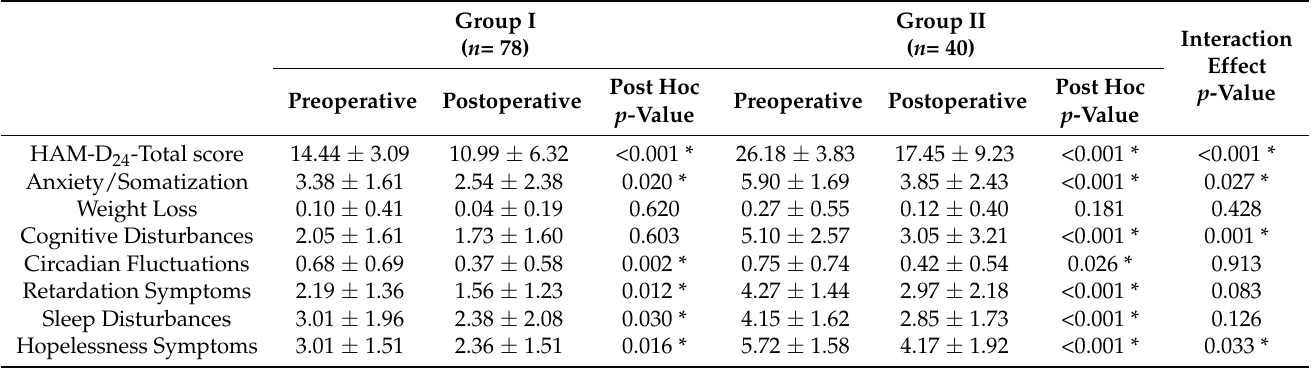
Table 2. Comparison of preoperative and postoperative HAM-D 24 total scores and subitems between groups. Group I ( n =